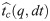
Average and median predictions of tc^(q,dt) as functions of tend for two different window size.(A) dt = 500 trading days. (B) dt = 750 trading days. tc^(q,dt) in each panel is obtained from quantile regressions with 99 values {q = 0.01, 0.02, …, 0.99} for the S&P 500 1987 bubble. The red horizontal and vertical dashed lines represent the true critical time Tc = 1987.10.19. The black tilted dashed line represents the diagonal line tc = tend.